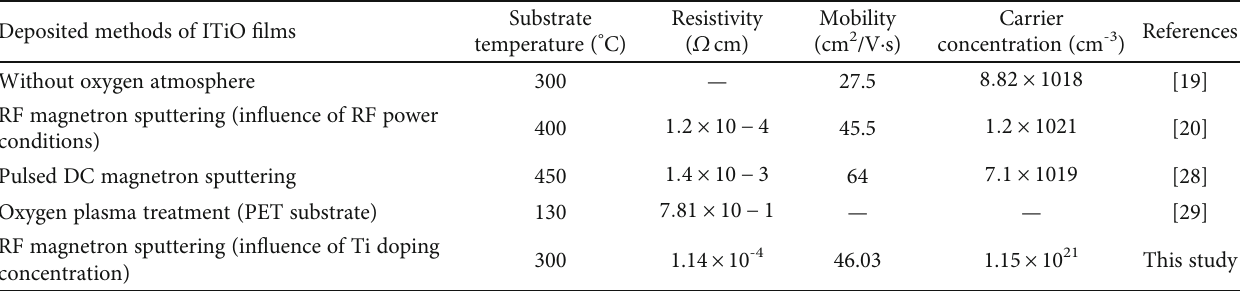
Substrate Resistivity Carrier References temperature ( ° C) (cm 2 /V · s) concentration (cm -3 ) 400